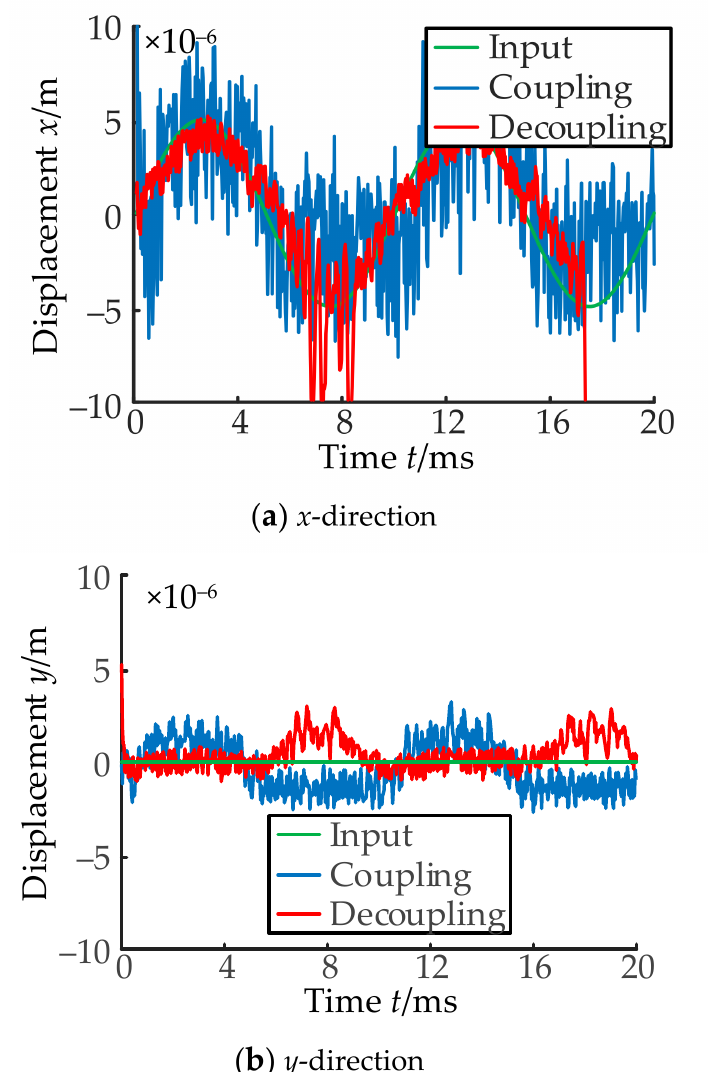
Figure 21. Displacement under sinusoidal signal in channel x . According to Figures 21 and 22, the rotor displacement before decoupling in the input channel presents the sinusoidal motion law with high-frequency oscillation as shown in the blue curve of Figures 21a and 22b. After decoupling, the decoupling controller effectively eliminates the oscillation and greatly improves the displacement with the characteristics as shown in the red curve of Figures 21a and